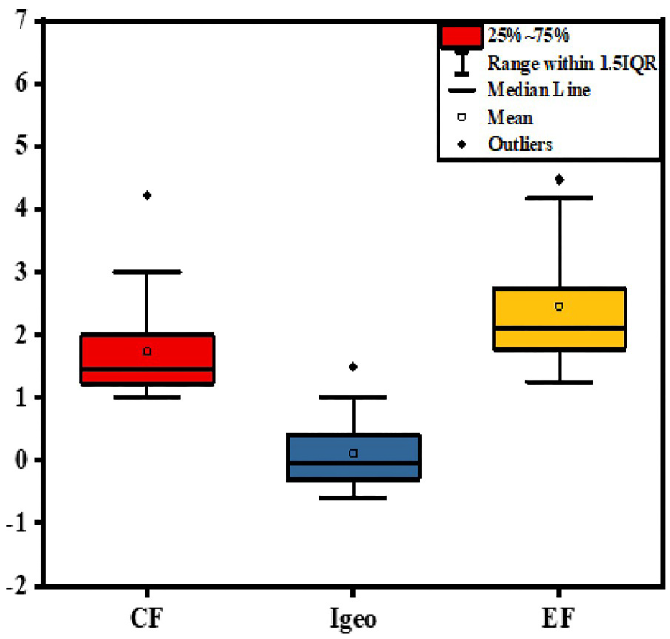
Figure 4. Box plot of Contamination factor (CF), geo-accumulation index (I geo ), and enrichment factor (EF) according to (McLennan, 2001) Nile River sediments.